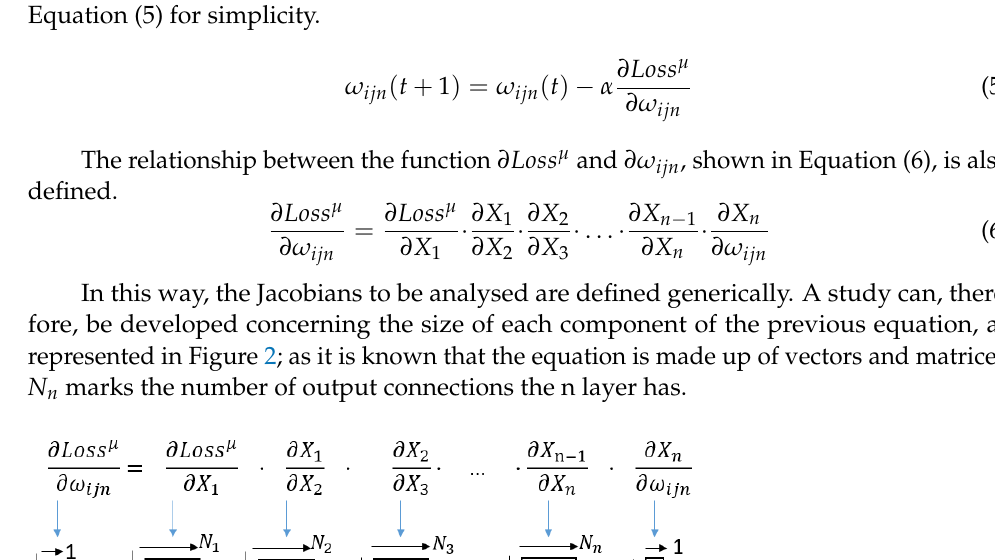
Figure 1. General representation of neural network layers.